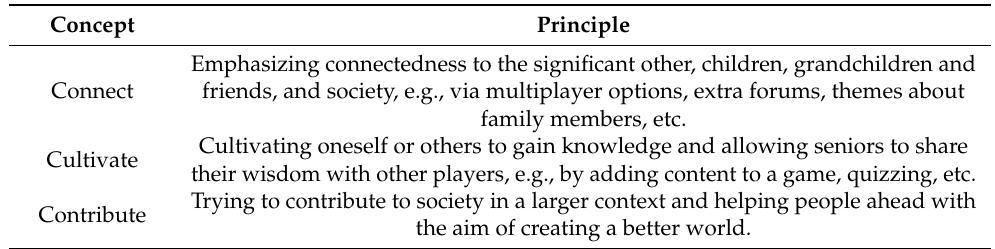
Table 1. Principles for designing meaningful games proposed by De Schutter and Vanden Abeele